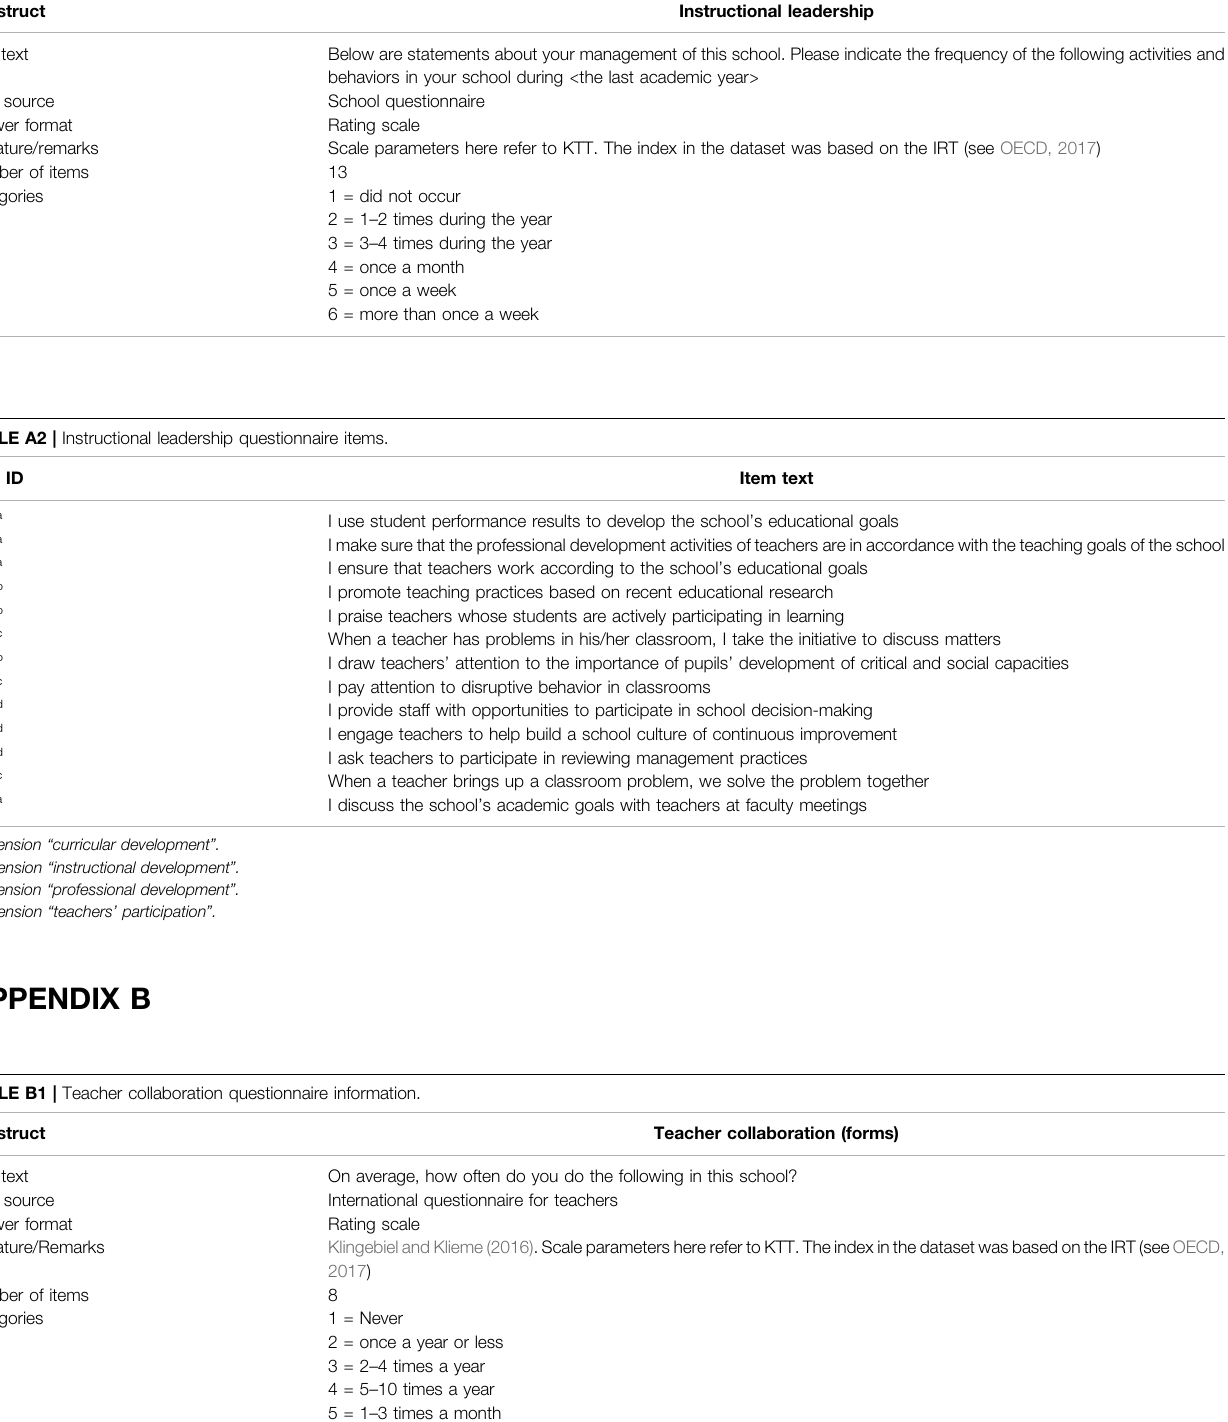
TABLE A1 | Instructional leadership questionnaire information. Construct Instructional